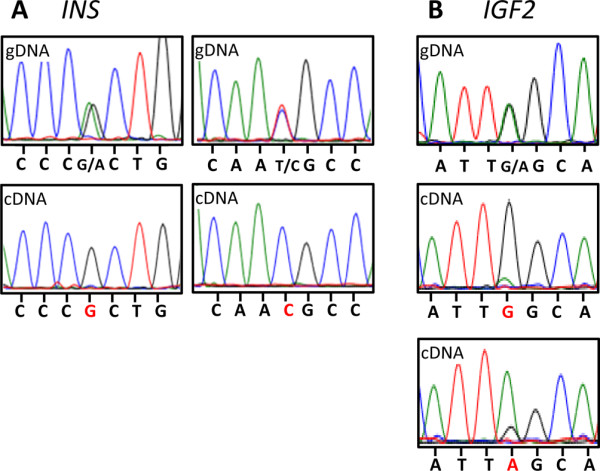
 Sequence chromatographs for imprint analysis in the mammary gland. Direct sequence analysis for insulin (INS) and insulin-like growth factor 2 (IGF2) imprinting in the mammary gland. (A) INS chromatogram traces (viewed in Finch TV version 5.1) for genomic DNA (gDNA) and cDNA. Two polymorphic sites were identified in gDNA, distinguishing the two alleles. In the mammary gland of seven individuals tested, two animals had monoallelic expression at both SNPs (site 1:G/A and site 2: C/T) and five animals had monoallelic expression in a single SNP (one individual at site 1and four individuals at site 2). (B) IGF2 chromatogram traces for gDNA (3′ to 5′) and cDNA (5′ to 3′). A single polymorphic site was identified in gDNA to distinguish the two alleles. Both alleles of IGF2 were monoallelically expressed in four different individuals (three animals expressed the G allele and one animal the A allele).